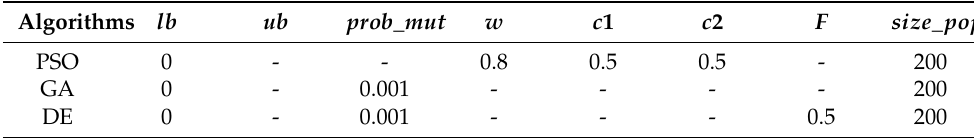
Table 3. Experimental parameter setting of baseline model. Algorithms